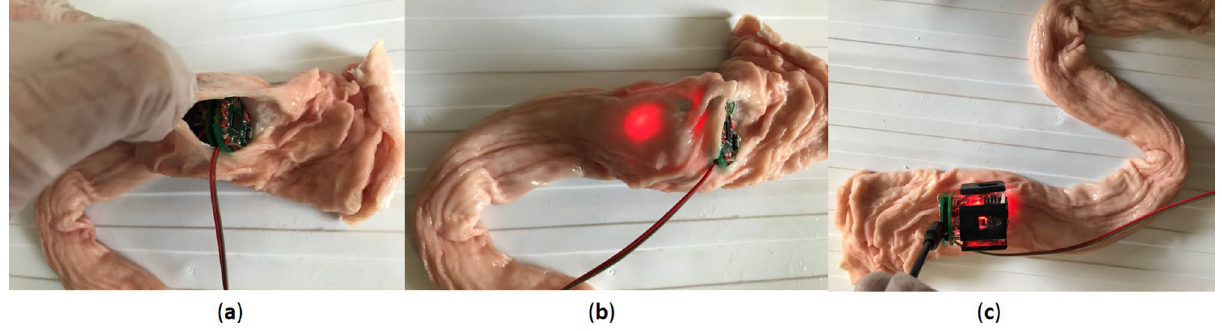
Figure 18. Test setup with porcine intestine.